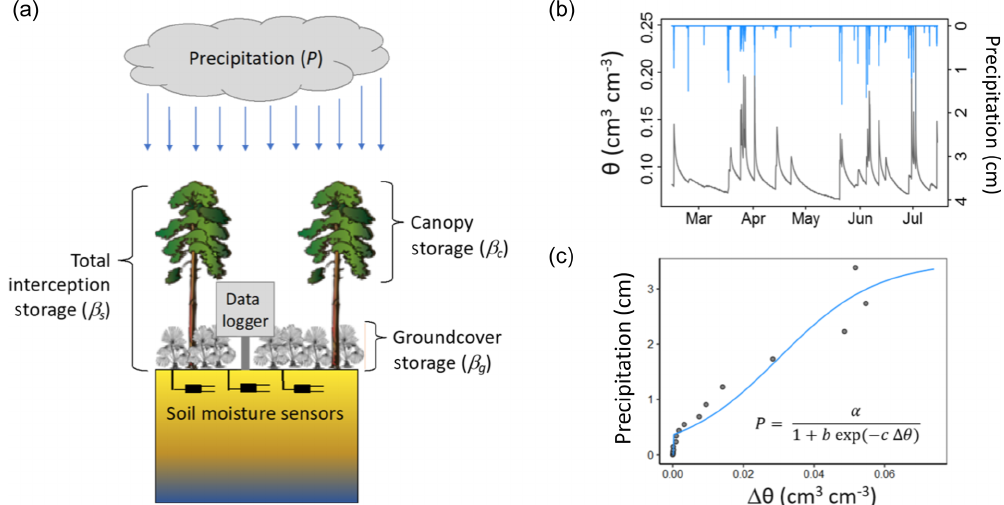
Figure 1. (a) Schematic illustration of experimental setup and interception water storages, where total interception storage ( β s ) is the sum of canopy storage ( β c ) and groundcover (understory and litter) storage ( β g ). (b) Example time series of rainfall (blue lines) and corresponding near-surface soil moisture content ( θ , black line; observed at 15cm in this study). (c) Resultant relationship between rainfall and change in soil moisture (cid:49)θ during rainfall, along with a fitted model to extract the y intercept (i.e., P s ).